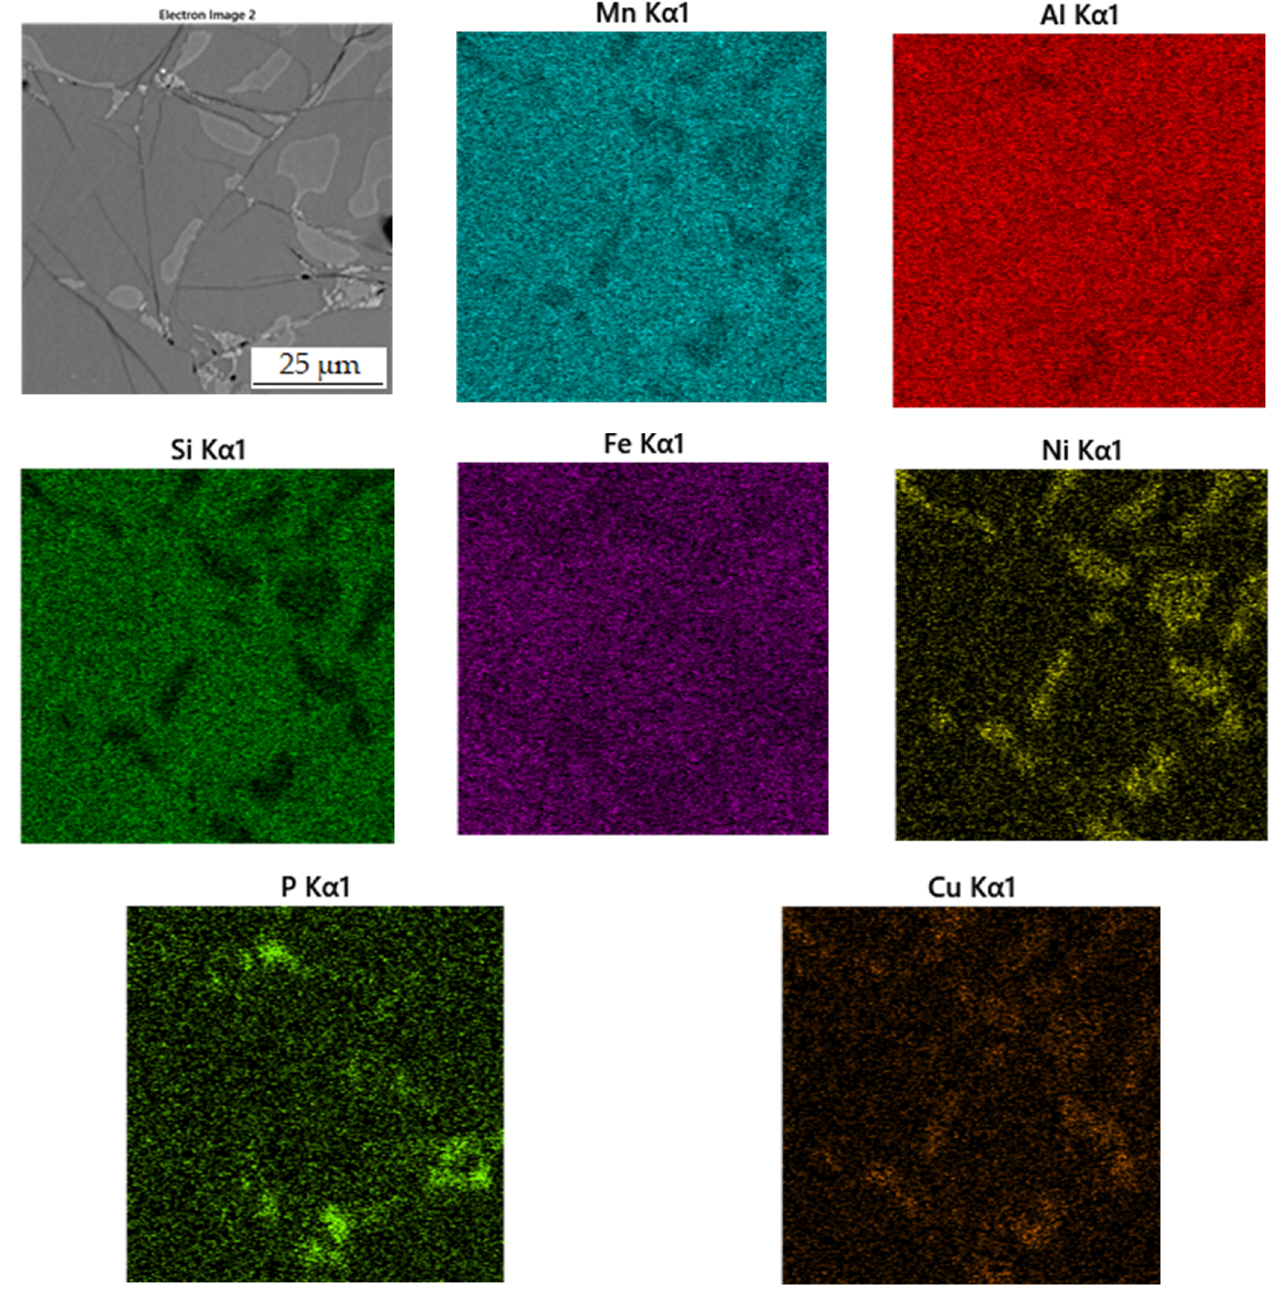
Figure 11. EDS map of the distribution of the elements in alloy sintered at 950 °C.